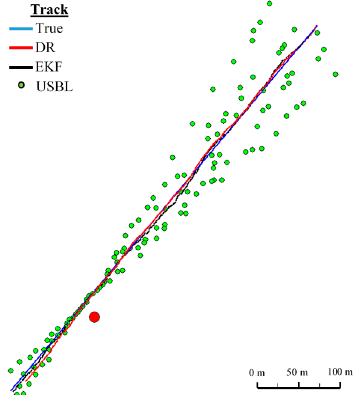
Figure 14. Determined routes (single passage).